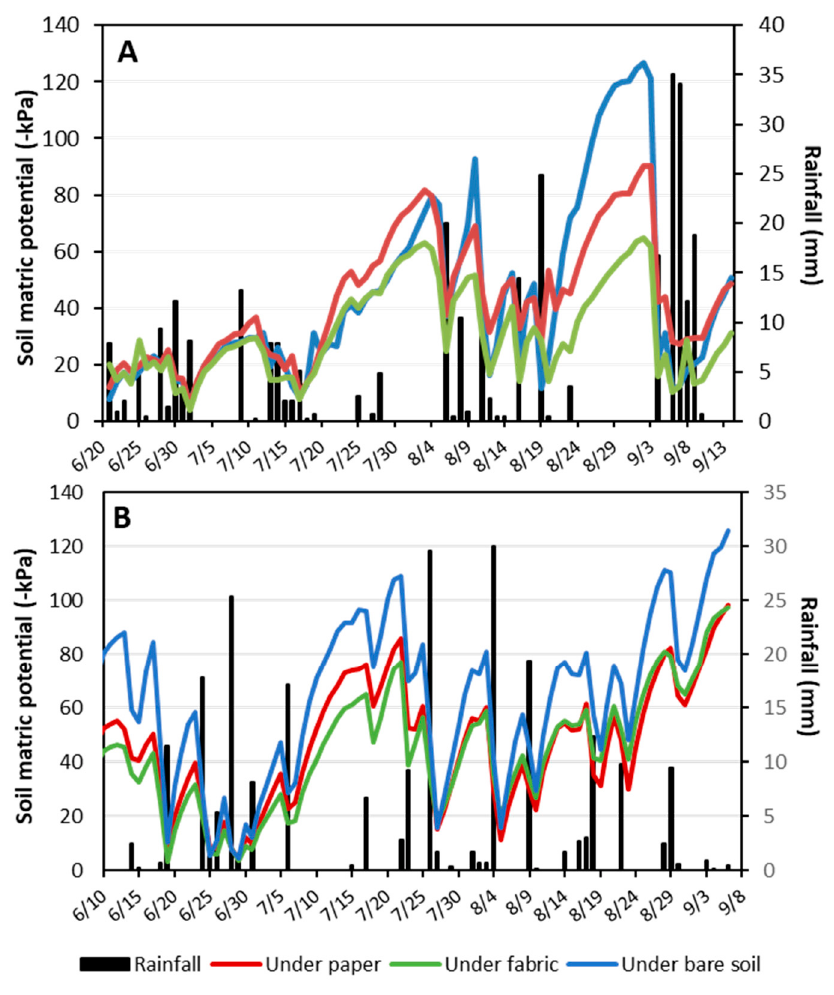
Figure 1. Daily rainfall totals and daily average soil moisture (soil matric potential) readings throughout the ( A ) 2017 and ( B ) 2018 growing season at organic vegetable field site in St. Albans, ME, USA, as measured within plots under a paper mulch weed barrier (under paper), under a woven polypropylene fabric mulch (under fabric), and outside of mulched plot boundaries representing bare soil (under bare soil). Table 3. Selected soil chemical properties and nutrient concentrations in spring 2018 as a ff ected by mulch type and soil amendments.